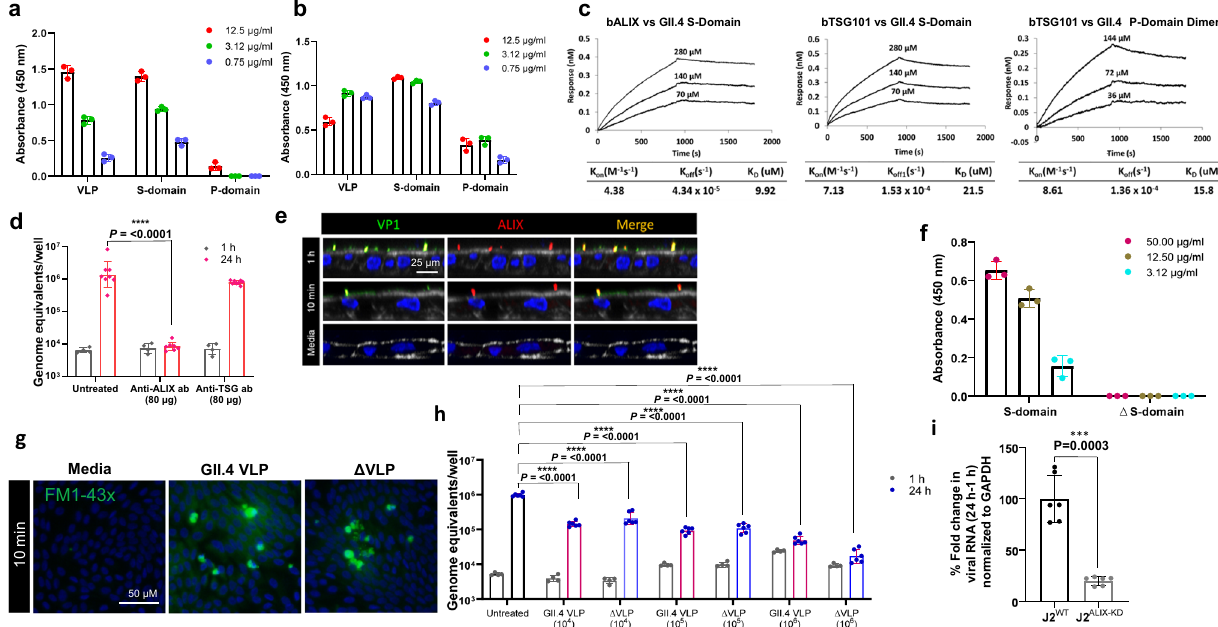
Fig. 4 | GII.4 interacts with ALIX and TSG101, withALIX being criticalfor virus entry.a GII.4VLP,SandPdomainbindingtoimmobilizedALIXbyELISA.Errorbars indicate mean±SD with three replicates. b GII.4 VLP, S and P domain binding to immobilized TSG101byELISA. Error bars indicate mean±SDwith three replicates. c Bio-Layer Interferometry (BLI) to determine the binding af fi nity of GII.4 S and P domains to biotinylated ALIX and TSG101 (bALIX and bTSG101). d Effect of blocking virus interaction with ALIX and TSG101 on viral replication using speci fi c pAbsat1h (gray) and 24h (pink).Error barsindicate mean±SDcalculated using2 HIE replicates for 1h and 4 HIE replicates for 24h (with two technical replicates/ sample). e Confocal microscopy to probe GII.4-ALIX colocalization on the cell surface by detecting VP1 (green) and ALIX (red) using Gp Syd-pAb and rabbitanti- ALIX pAb. f ELISA to evaluate binding of GII.4 S- and mutant Δ S-domains to immobilized ALIX. Error bars indicate mean±SD with 3 replicates. g Endocytosis